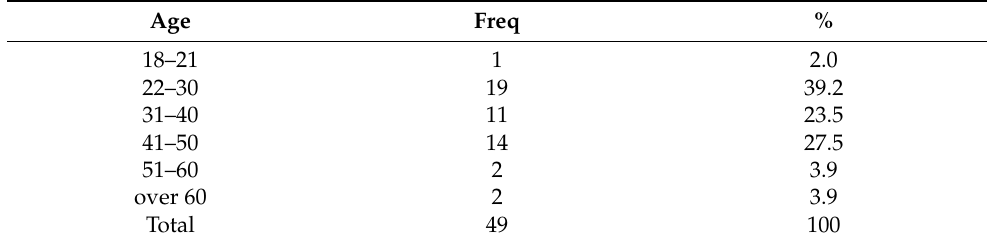
Table 1. Age group of male perpetrators.